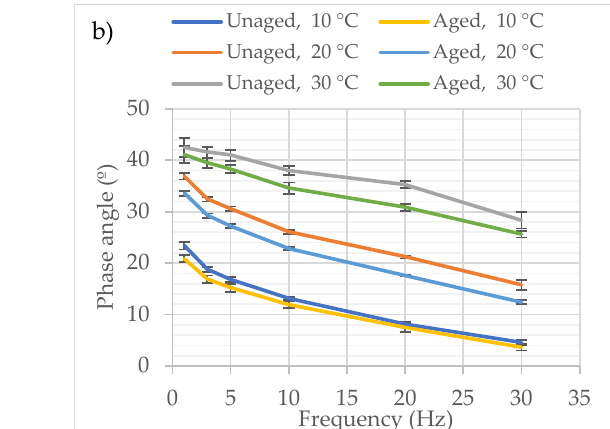
Figure 3. Stiffness modulus of the control ( a ) and modified ( b ) SMA 8 in unaged and aged conditions.